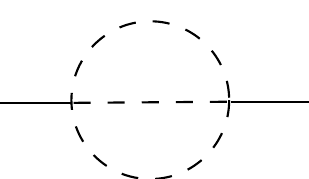
Figure 14. Setting sun diagram for h(cid:30)(cid:31) 3 = 3! interaction. Solid and dashed lines correspond to (cid:30) and (cid:31) ,